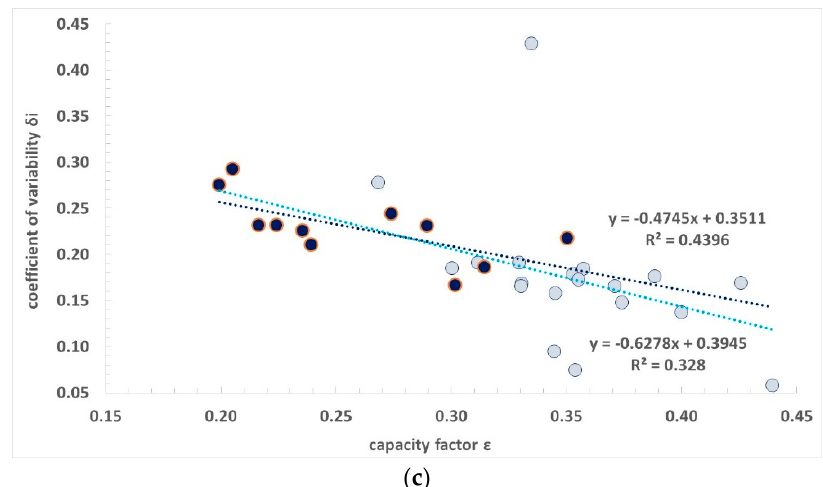
Figure 11. Summary results of δ s and δ i of the different units of WEF of Tables 2–7, and of the WEF of Table 8, having a minimum of 3 years of data to compute δ i (maximum was 5 years of data), as well as of the Alta Wind units only. δ s was computed for the year 2016 where most parts of the data were available, and for the year 2017 when the full year 2016 was not available. A marker with a darker color is used for the Alta Wind units. ( a ) δ s vs. δ i ; ( b ) δ s vs. ε ; and ( c ) δ i vs. ε . δ s was reducing linearly with ε , with a proportionality factor much larger than unity. δ i was also reducing linearly with ε , but with a proportionality factor much smaller than unity.